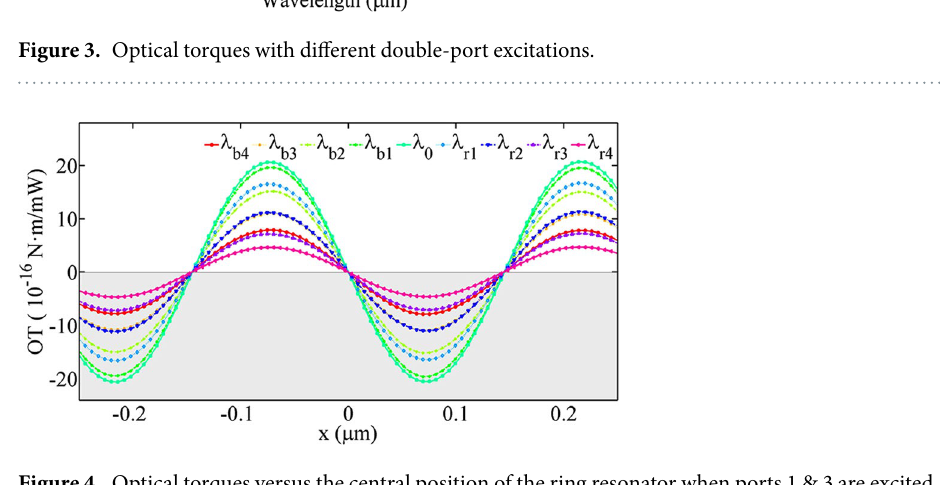
Figure 4. Optical torques versus the central position of the ring resonator when ports 1 & 3 are excited simultaneously with the same frequency and power. OT can be tuned sinusoidally with the position in this